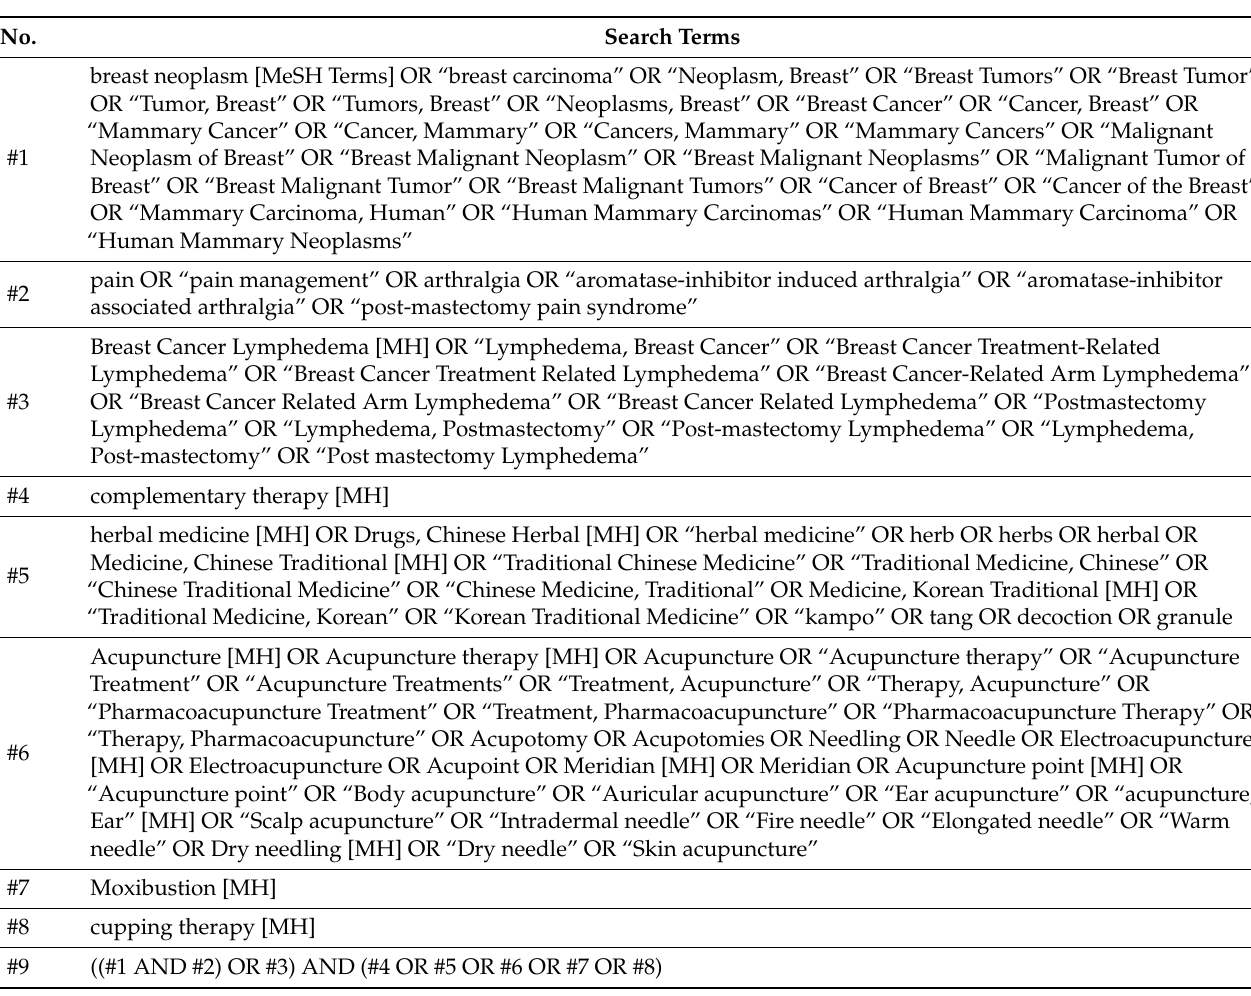
Table 1. Search Strategy for